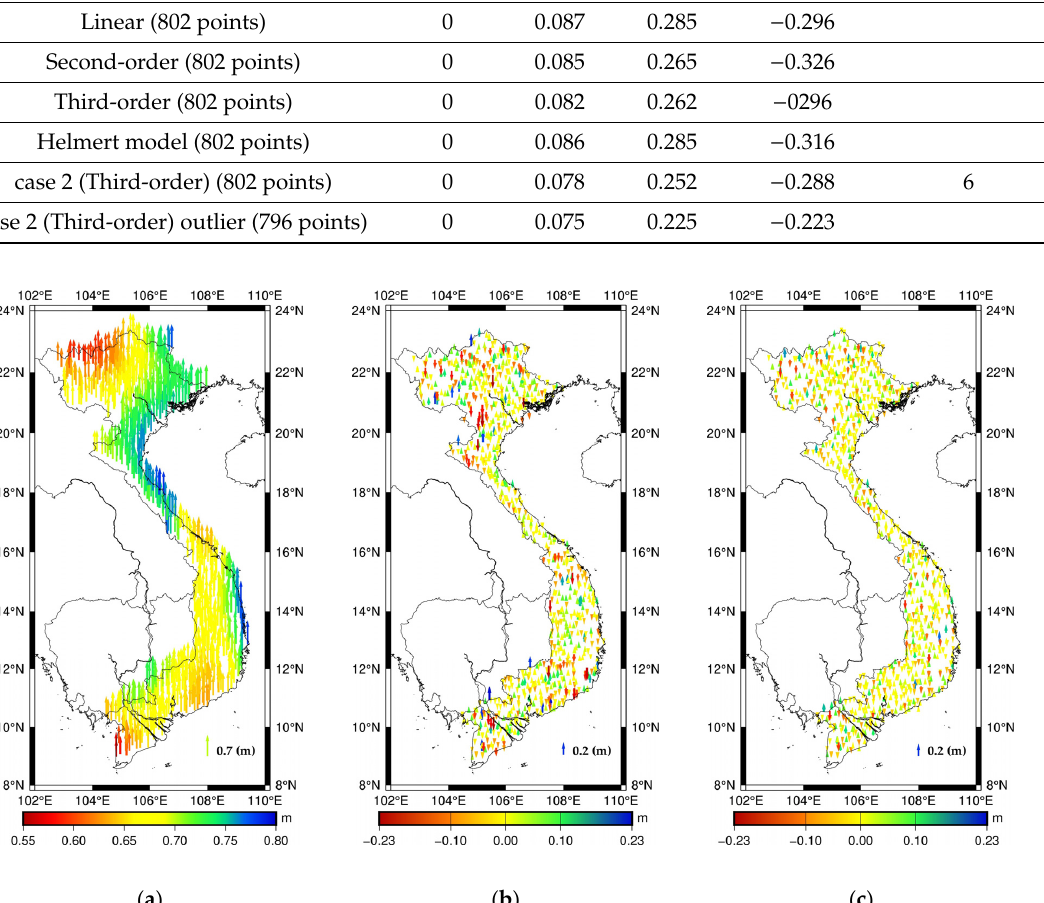
Figure 7. ( a ) Distortions, ( b ) residuals and ( c ) differences between the 779 GNSS/levelling points and gravimetric quasigeoid model adding offset model.